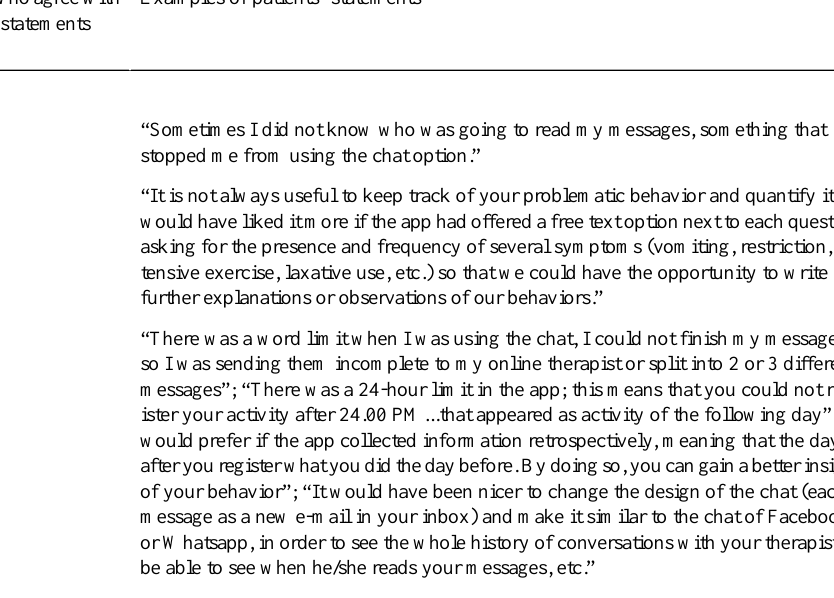
Examples of patients´ statementsPatients who agree